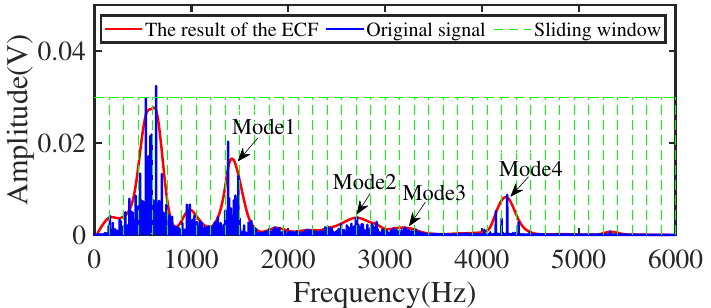
Figure 1. The result of envelope curve fitting.